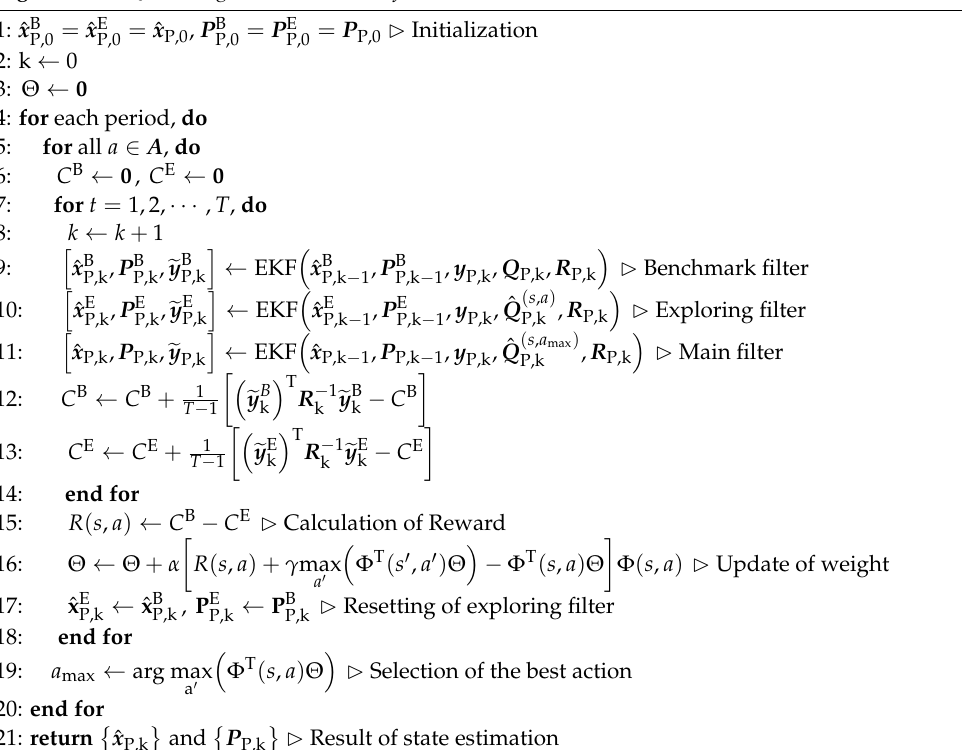
Algorithm 1 : Q-learning extended Kalman